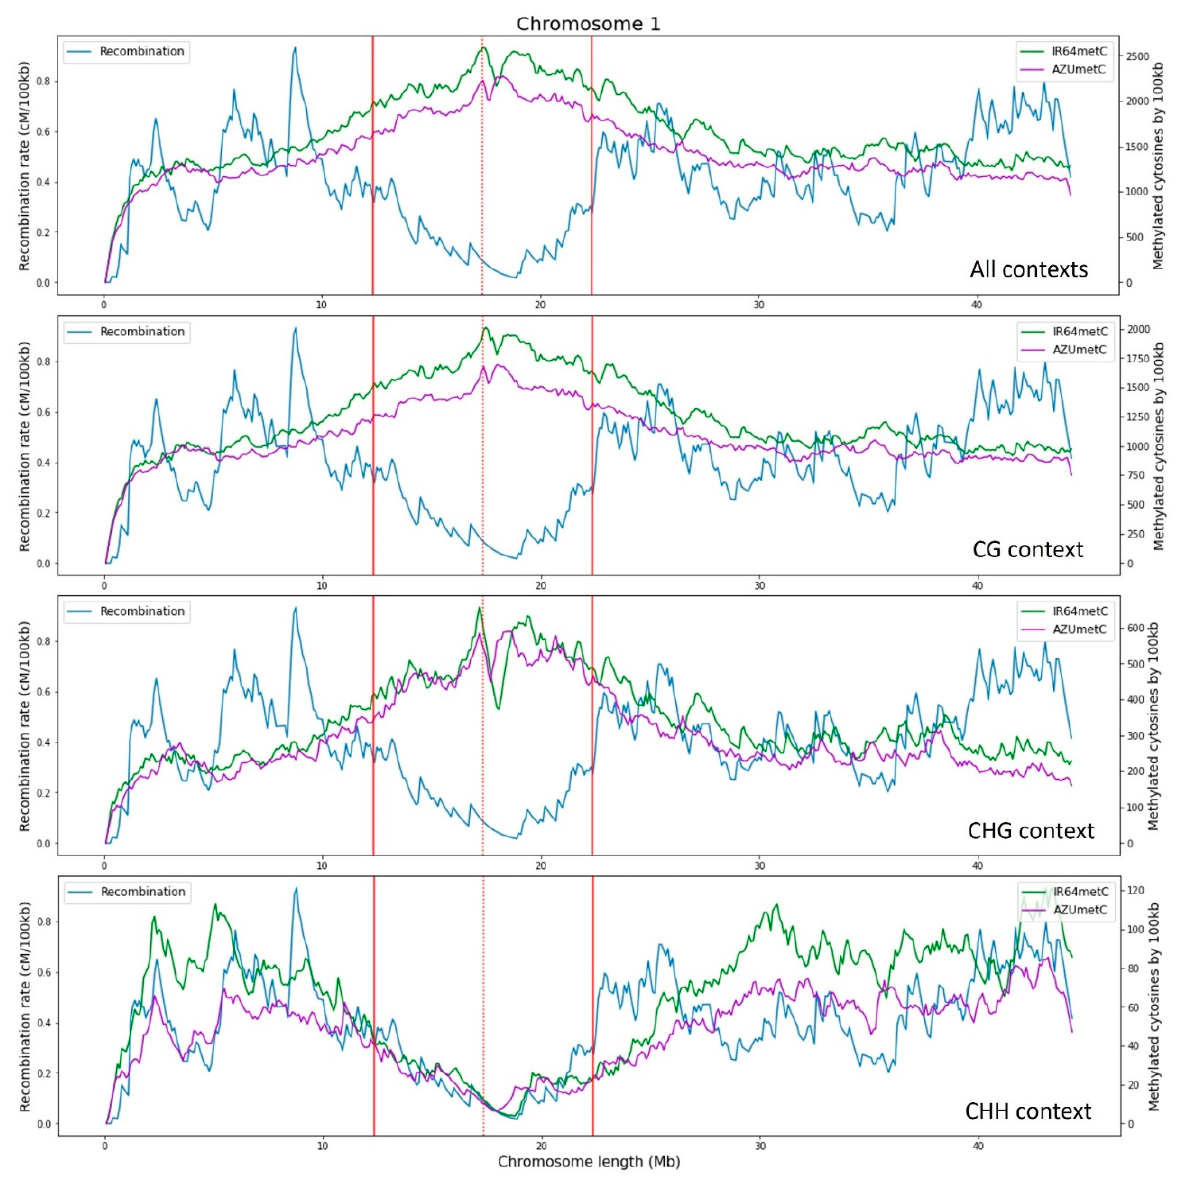
Figure 1. Recombination and methylated cytosines through Chromosome 1 for the rice varieties IR64 and Azucena. The centromere is represented by a red dotted line and the influence of the centromere region by solid red lines.